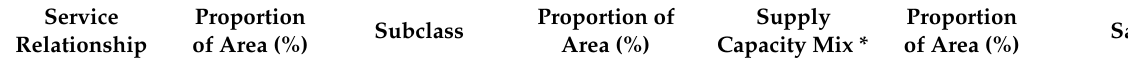
Table 3. Classification criteria and statistics of trade-offs and synergies among the five ES